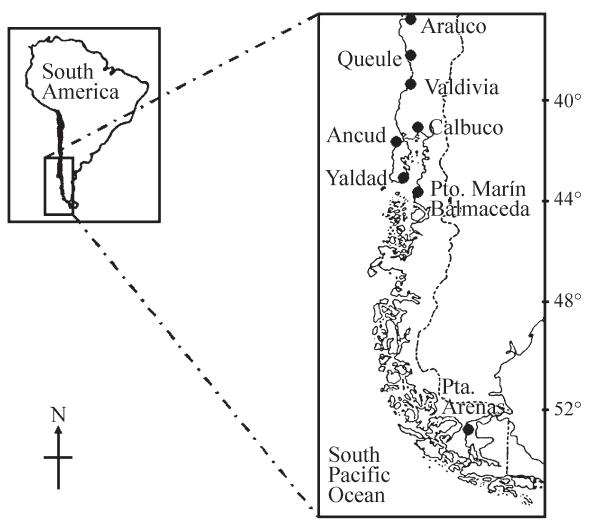
Figure 1 - Locations of the eight natural populations of the chilean blue mussel ( Mytilus chilensis ) sampled along its whole natural distribution in southern Chile ((cid:127)).